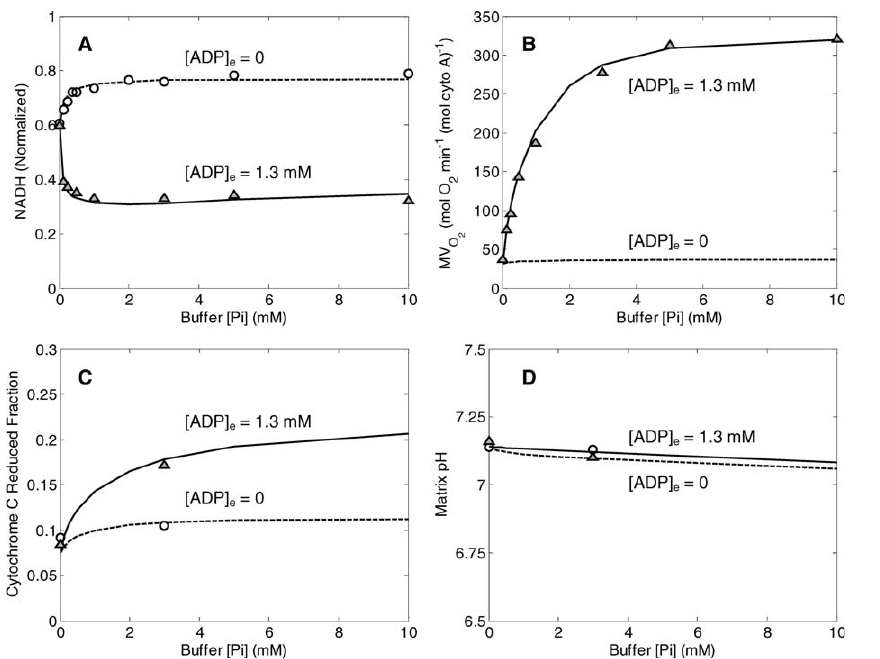
Figure 4. Comparison of Model Simulations to Experimental Data on NADH, MV O2 , Cytochrome C Redox, and Matrix pH for Model with Phosphate Control (A) Results for normalized matrix NADH as a function of buffer inorganic phosphate concentration are shown for the two experimental cases of resting mitochondria ([ADP] e ¼ 0, state 4) and active state mitochondria ([ADP] e ¼ 1.3 mM, state 3). (B) Results for MV O2 (rate of oxygen consumption) are shown for the same experimental cases as in (A). (C) Results for cytochrome C reduced fraction are shown for the experimental cases as in (A). (D) Matrix pH (model-simulated and experimentally measured) is plotted as a function of buffer phosphate for the experimental cases as in (A). All computed results in this figure correspond to steady-state simulations of the model described under ‘‘ Mitochondrial Model with Phosphate Control. ’’ Model simulations for [ADP] e ¼ 1.3 mM and [ADP] e ¼ 0 mM are plotted as solid lines and dashed lines, respectively; experimental data are the same as plotted in Figure 2. DOI: